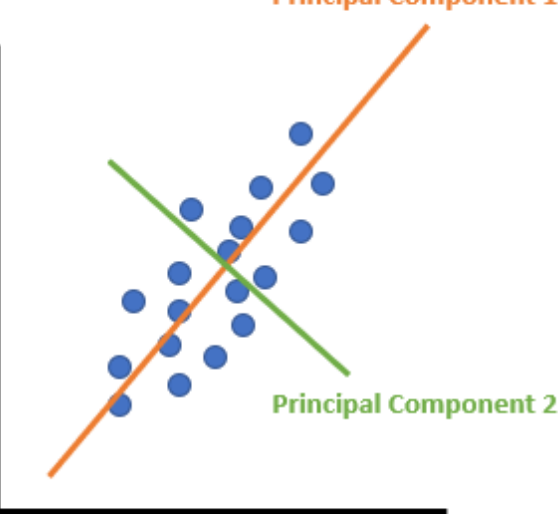
Figure 2. Visual Representation of principal component analysis.